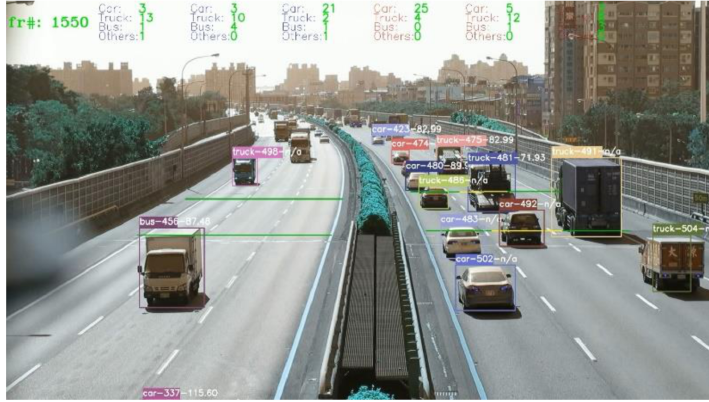
Figure 11. The velocity level of each lane in the video taken on National Freeway